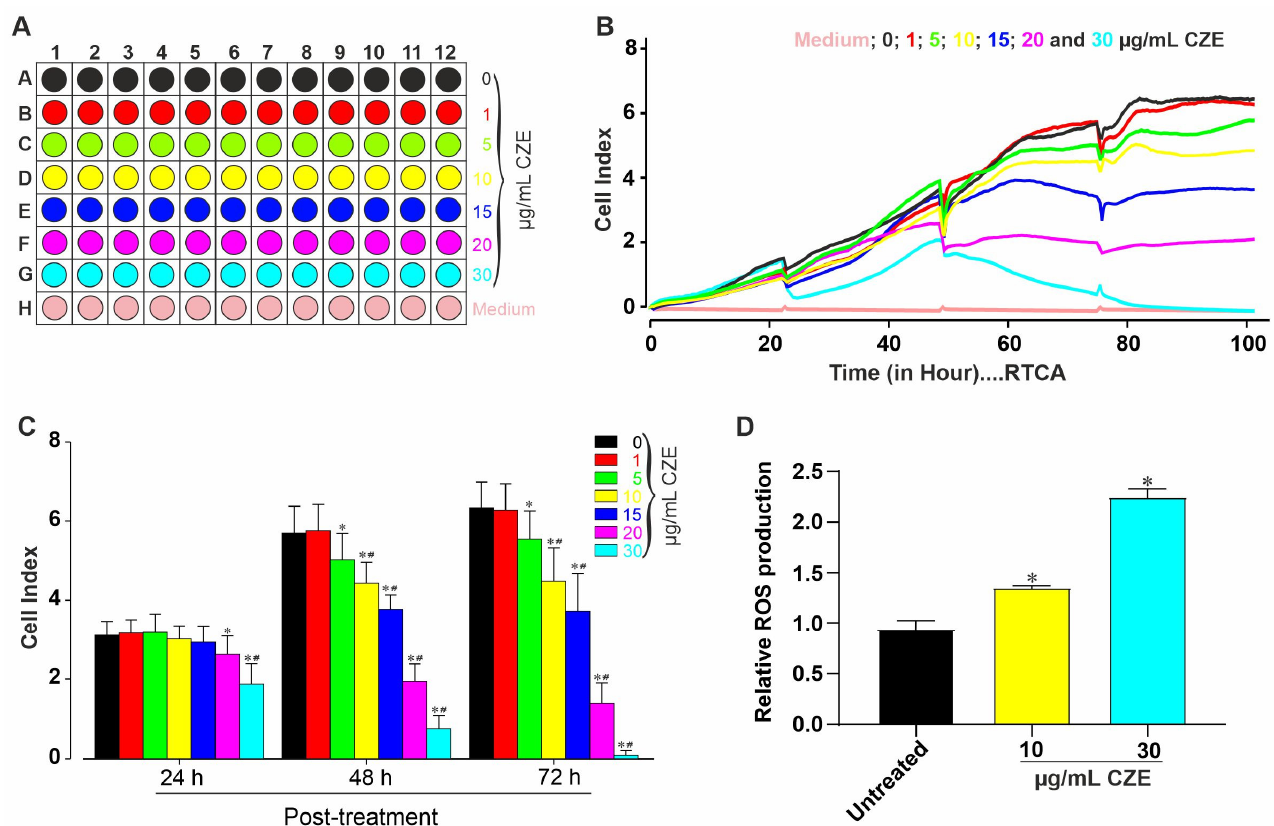
Figure 1. Monitoring the cytotoxicity effect and reactive oxygen species (ROS) production of the methanolic extract of Crinum zeylanicum (CZE) in mouse induced pluripotent stem cells (miPSCs). ( A ) Diagram showing 96-well plate design. ( B ) Representative traces showing changes in cell index, the parameter of cell viability, after 100 h of treatment with different concentrations of CZE. ( C ) Peak cell index values 24, 48, and 72 h post-treatment with 0 (negative control), 1, 5, 10, 15, 20, and 30 µg/mL CZE. ( D ) Effect of CZE on ROS production, level of ROS in untreated (control) and CZE-treated cardiomyocytes with 10 µg/mL and 30 µg/mL. Data are presented as the mean ± SEM of at least six wells for each of the three independent experiments. * p < 0.05 and # p < 0.05, significantly different compared to negative control and previous low concentration, respectively. Control wells are indicated as medium: no CMs and culture medium only.